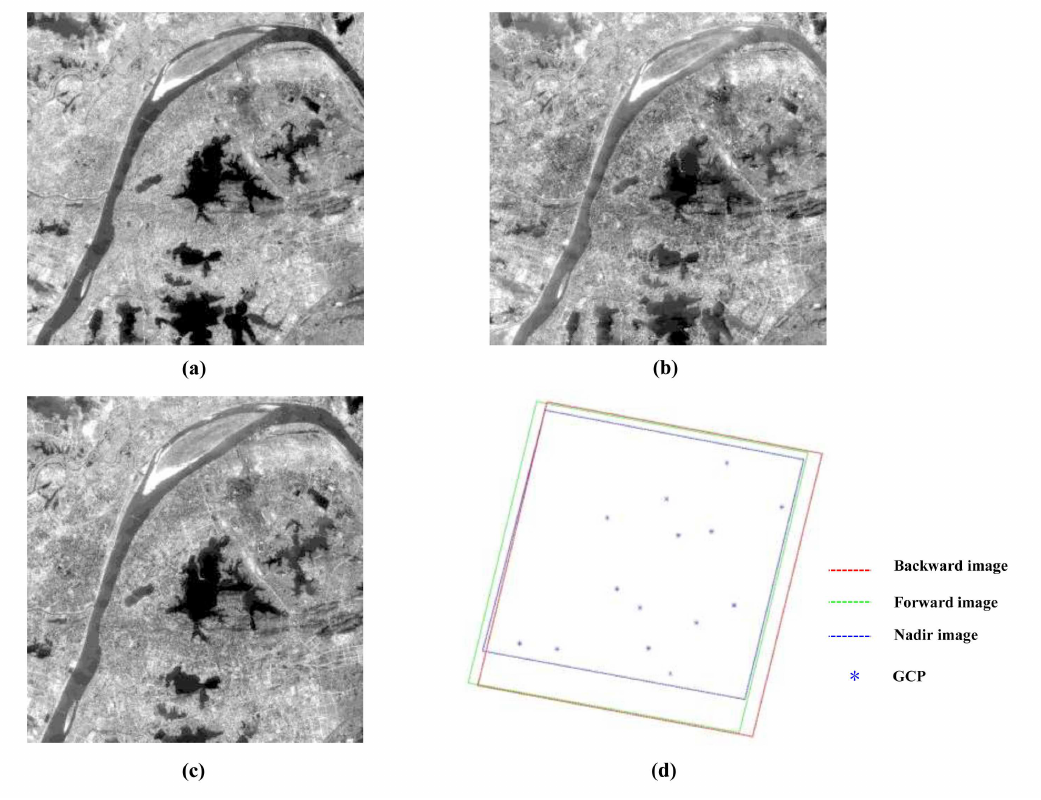
Figure 4. Three ZY-3 images and the distribution of ground truth points: ( a ) Backward; ( b ) Forward; ( c ) Nadir; ( d ) The extents of three images and the distribution of GCPs.